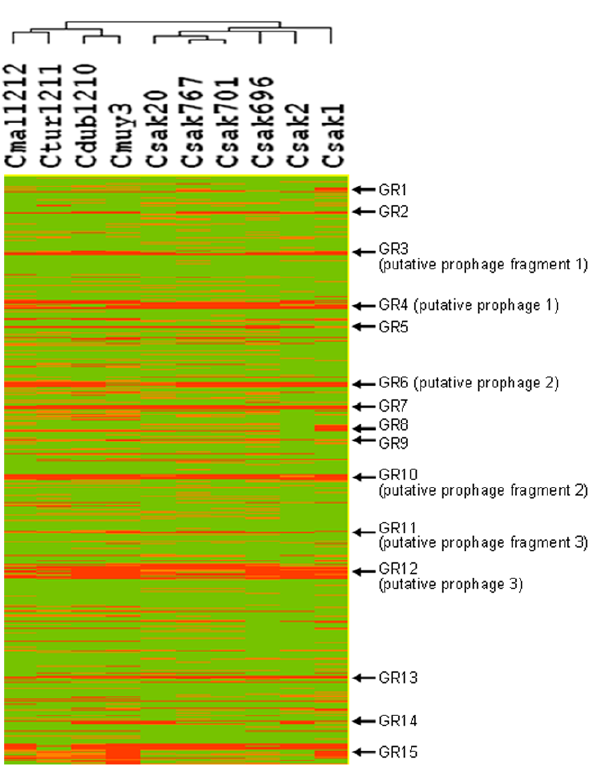
Figure 1. Whole genome clustering analysis showing the relationship between 10 Cronobacter isolates. Genomic regions GR1–GR15 are marked. Clustering analysis was performed using Gene Cluster (EisenSoftware). Hierarchical clustering was performed using the average linkage method on the trinary matrix based on the CGH analysis (1 for presence, 0 for uncertain and 2 1 for absence/divergence of a gene). For description of strains refer to Table 1.